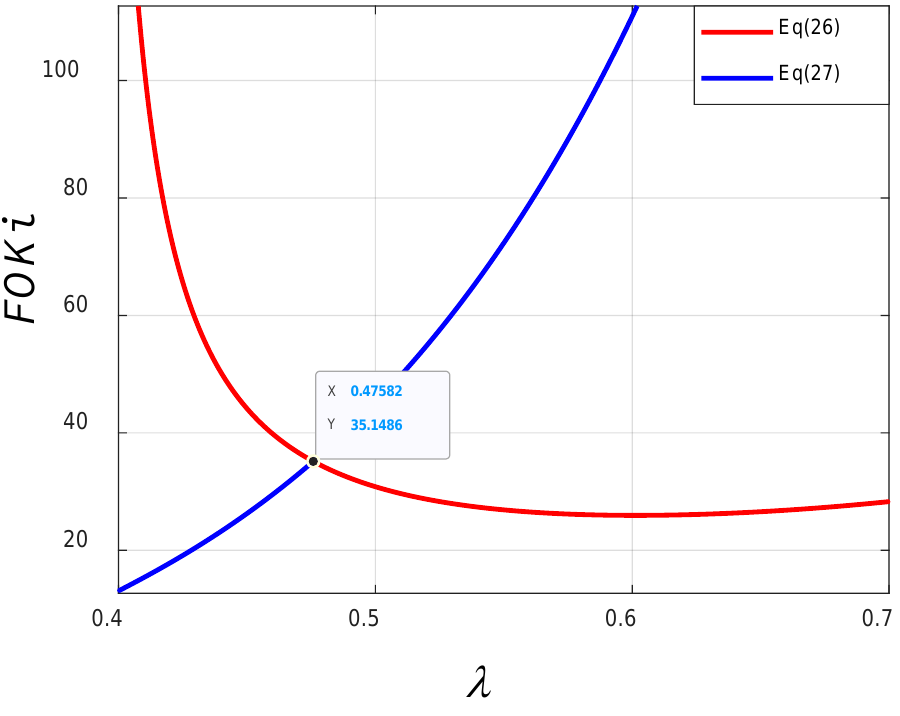
Figure 5. The tuning result of FOK i and λ